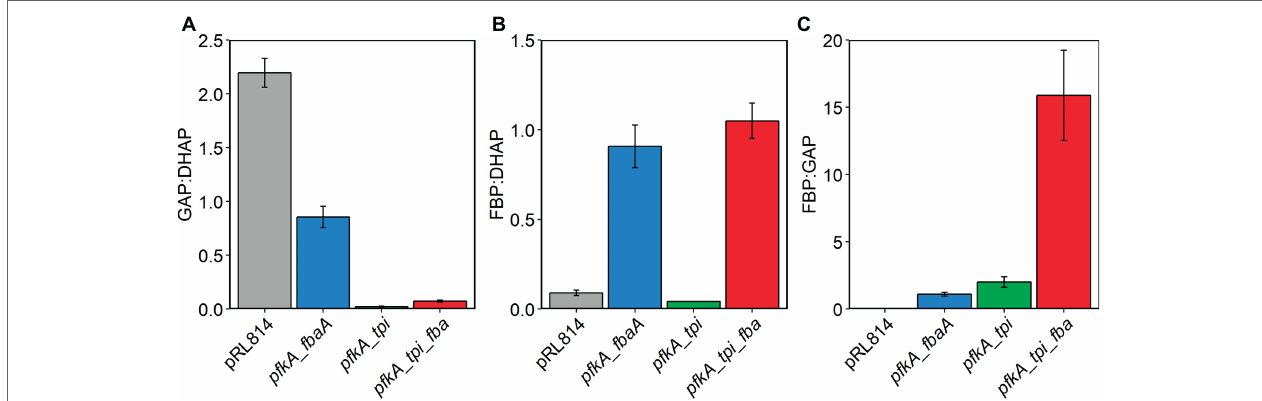
FIGURE 5 | Relative concentrations of EMP metabolites in Z. mobilis ZM4 expressing EMP enzymes. Cells were grown and cellular metabolites were analyzed by LC/MS as described in the legend of Figure 4 . Concentrations of metabolites were calculated from LC/MS signals and response factors of relevant metabolite standards. (A) GAP:DHAP, (B) FBP:DHAP, and (C) FBP:GAP.